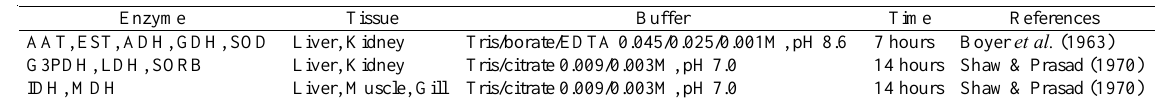
Table 1. Electrophoretic conditions for 10 enzymatic systems assayed for Gymnotus inaequilabiatus , G . sylvius and G . pantanal from Caracu stream, Paraná State, Brazil. Enzyme Tissue Buffer Time